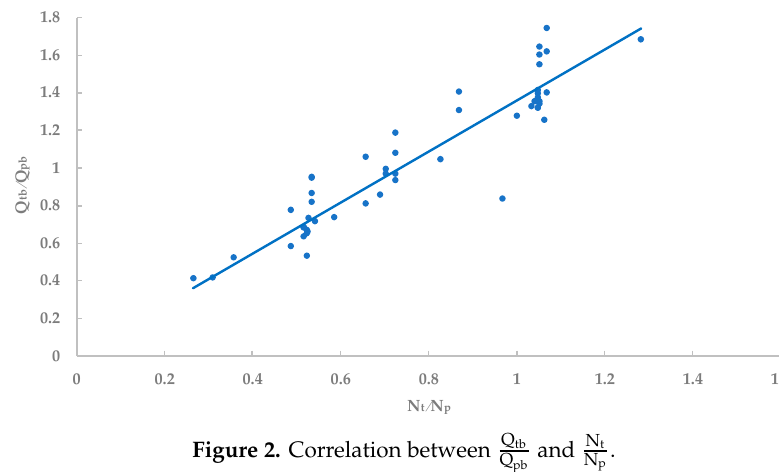
and N t . Q pb N p N (cid:2930) (cid:3416) and N (cid:2926) (cid:3416) . (cid:2926)(cid:2912) N (cid:2930) (cid:3416) and N (cid:2926) (cid:3416) . (cid:2926)(cid:2912)